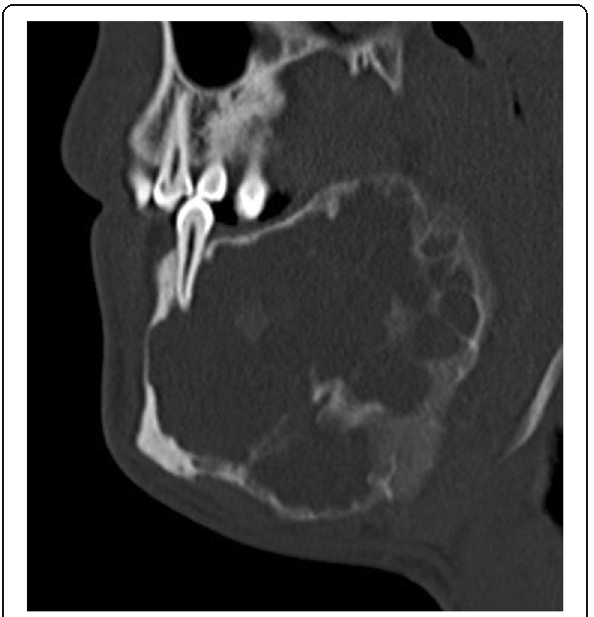
Fig. 2 Sagittal cross-section of the tumour reveals many cystic spaces in the solid part, mirroring the computed tomography